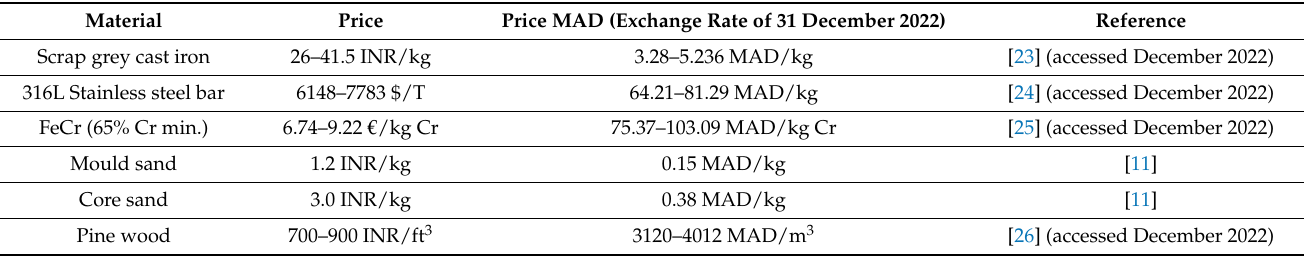
Table 1. Values used for the cost estimation with